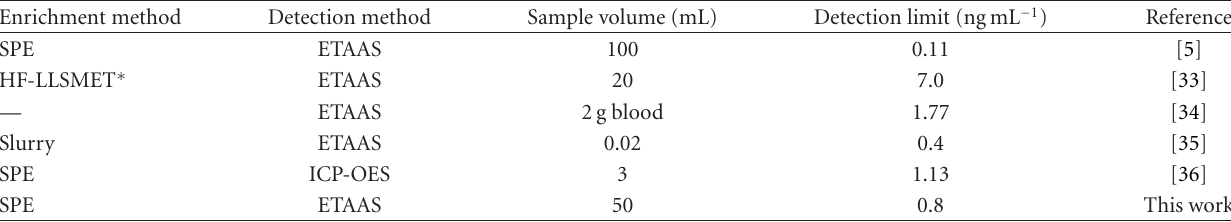
Table 4: Comparison of the proposed methods with the other